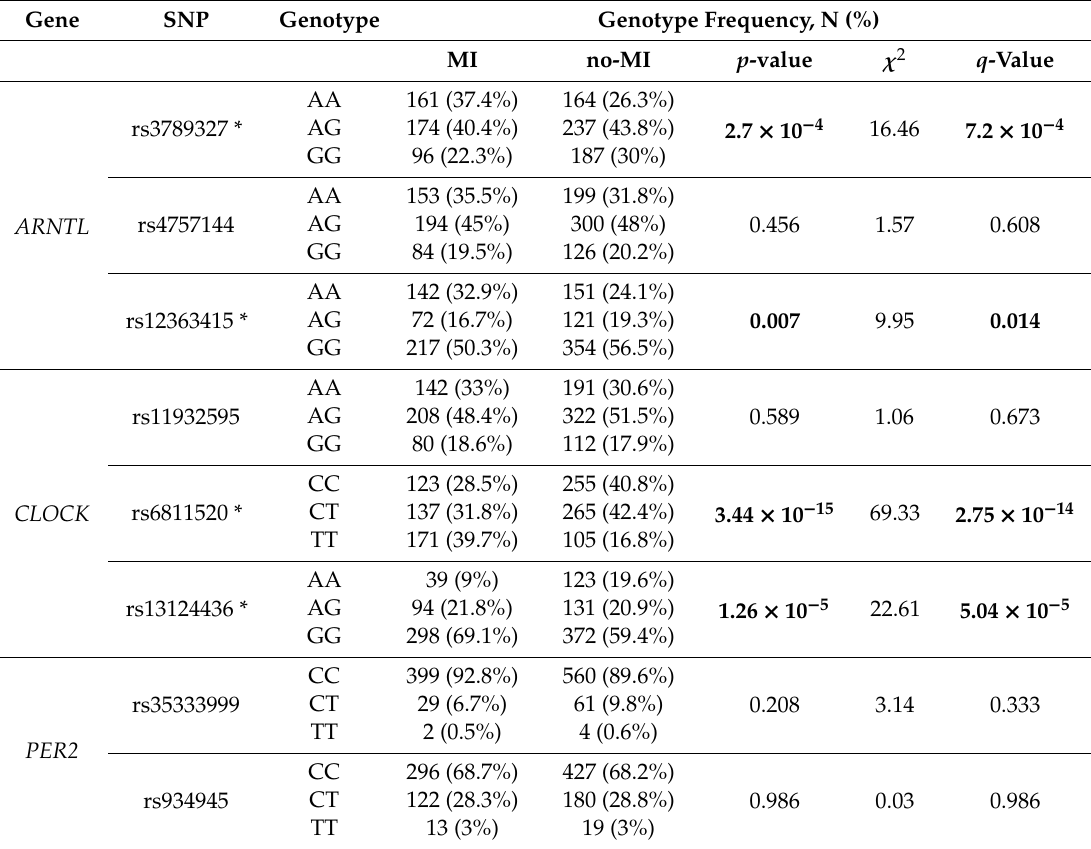
Table 4. Genotype distribution and frequencies of the ARNTL , CLOCK , and PER2